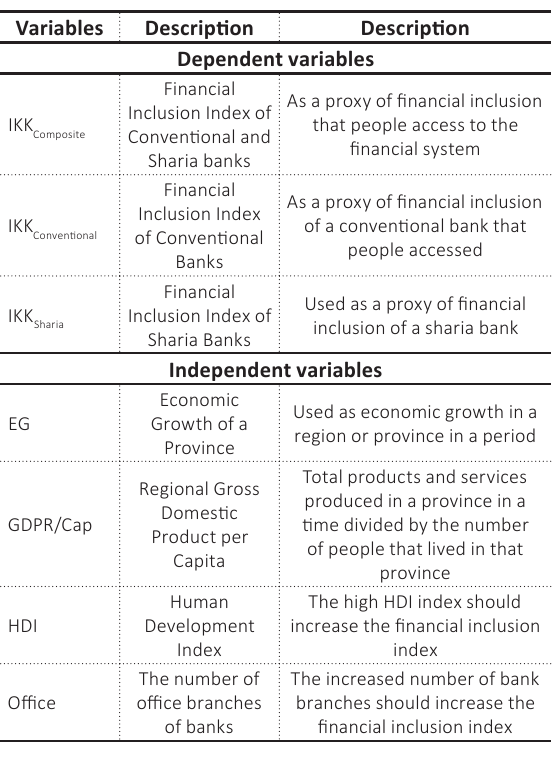
Table 1. Research